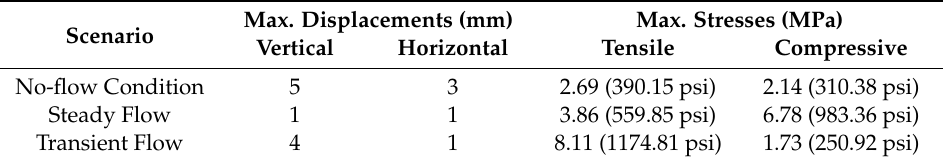
Table 3. Maximum displacements and stresses under each